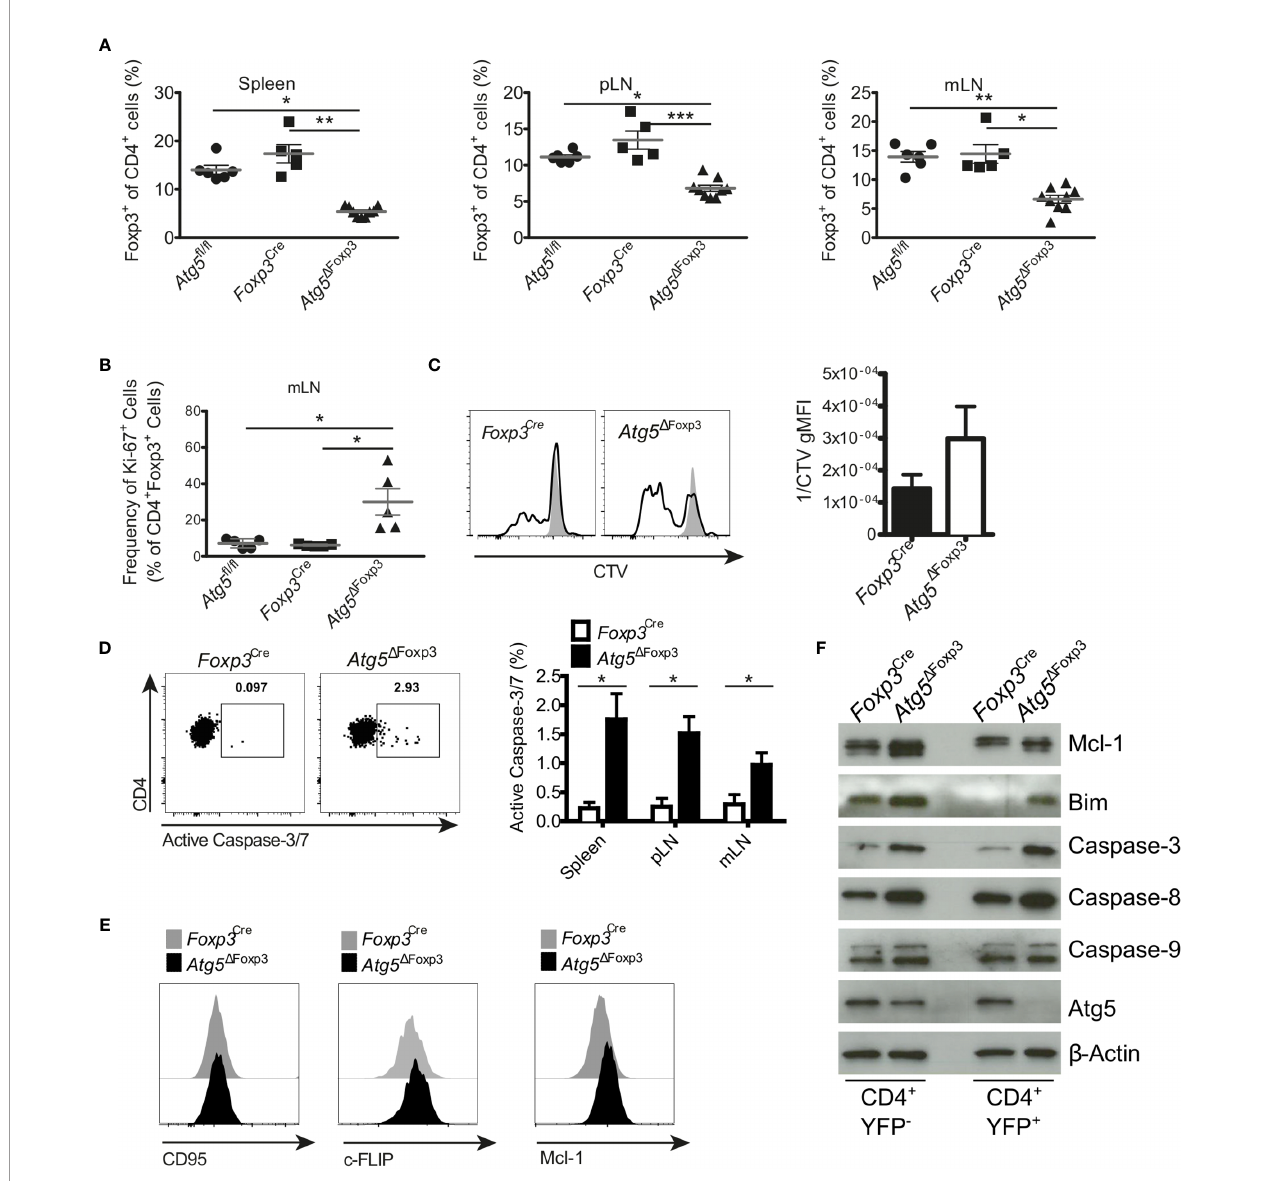
FIGURE 4 | Enhanced apoptosis in Atg5-de fi cient Treg cells. (A) Percentages of CD4 + Foxp3 + cells of spleen, peripheral lymph node (pLN) and mesenteric lymph node (mLN) from 11-20-week-old Atg5 fl / fl , Foxp3 Cre and Atg5 D Foxp3 mice. (B) Frequency of Ki-67 + within CD4 + Foxp3 + cells from mesenteric lymph nodes of Atg5 fl / fl , Foxp3 Cre and Atg5 D Foxp3 mice. (C) Cell trace violet (CVT) labeled Treg cells from Atg5 D Foxp3 and Foxp3 Cre mice were stimulated in vitro with anti-CD3, anti-CD28 and IL-2 (black line), or left unstimulated (grey). Proliferation as indicated by CVT dilution was quanti fi ed on day 3 via fl ow cytometry. Bar graph shows Mean ± SEM of 2 independent experiments. (D) Representative dot plots and summary bar graph of active Caspase-3/7 staining in Treg cells of Foxp3 Cre and Atg5 D Foxp3 mice. Bar graph shows mean ± SEM (n=4 each); Statistical analyses were performed by two-tailed Mann-Whitney tests. (E) Histograms of CD95, c-FLIP and Mcl-1 expression in Treg cells from Atg5 D Foxp3 (black) and Foxp3 Cre mice (grey) mice determined by fl ow cytometry. (F) Immunoblot analysis of apoptosis-related proteins in FACS- puri fi ed Tcon (CD4 + YFP - ) and Treg (CD4 + YFP + ) cells from Atg5 D Foxp3 and Foxp3 Cre mice. (A, B) The Kruskal – Wallis one-way ANOVA tests were used for statistical analysis. Mean ± SEM are given. Each symbol represents a single mouse in the scatter plots. *p < 0.05, **p < 0.01, ***p <